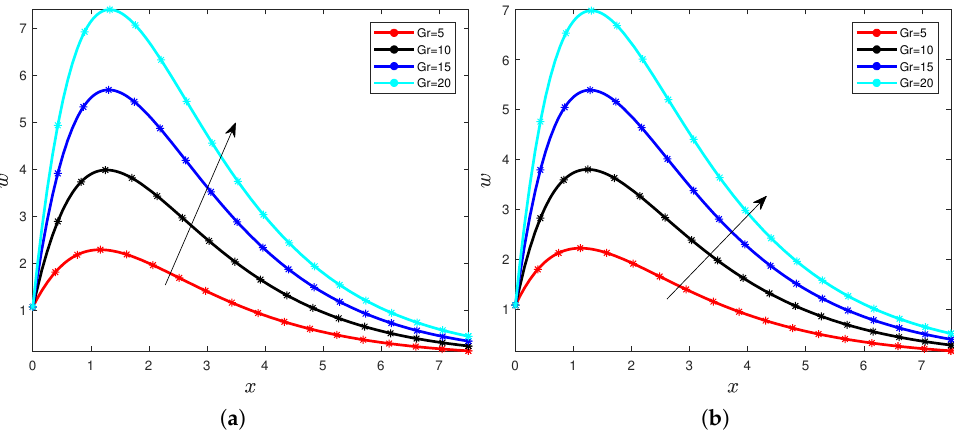
Figure 6. Velocity for different values of the Casson parameter η = 0.5 ( a ) and η = 1 ( b